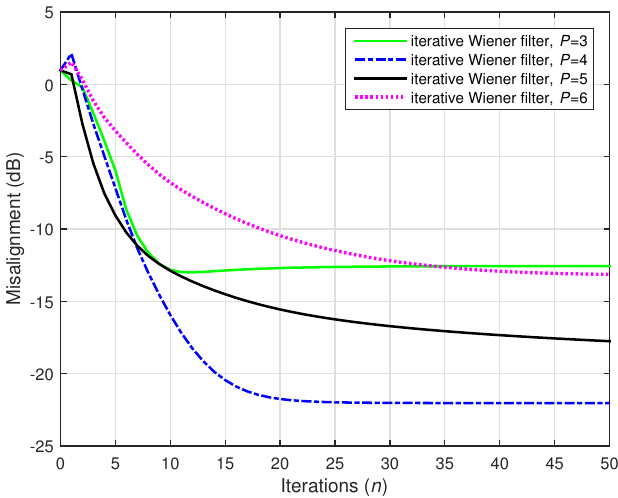
Figure 11. Performance of the iterative Wiener filter with different values of P , using N = 1000. The input signals were independent AR(1) processes, M = 4, L = 500, and SNR = 30 dB.